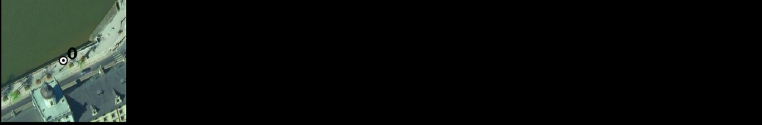
Figure A4. GWT minimum outliers